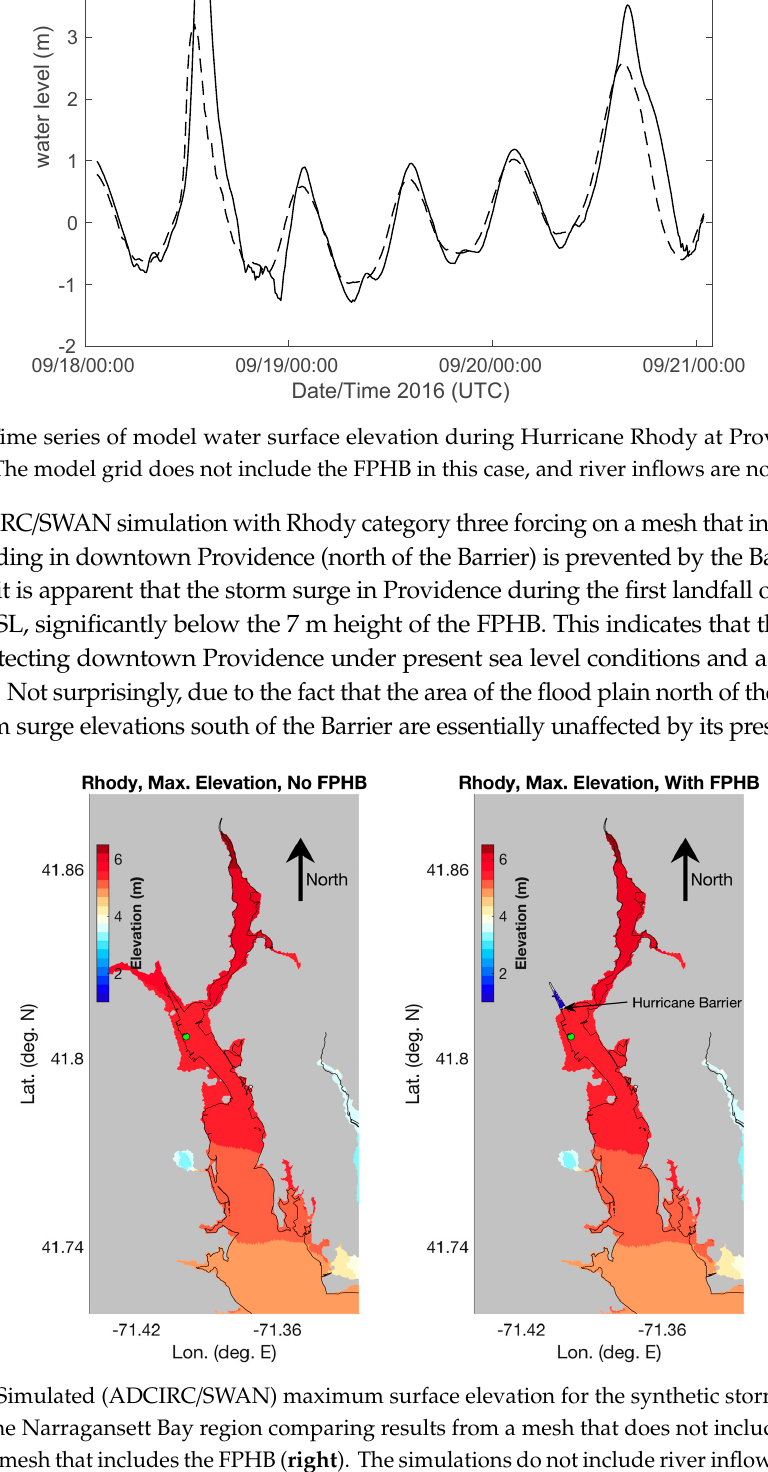
Figure 10. Simulated (ADCIRC / SWAN) maximum surface elevation for the synthetic storm Hurricane Rhody in the Narragansett Bay region comparing results from a mesh that does not include the FPHB ( left ) and a mesh that includes the FPHB ( right ). The simulations do not include river inflows. The black line represents the coastline, and colored areas shoreward of the coastline represent areas experiencing overland flooding. The green circle denotes the location of the Providence tide gauge.